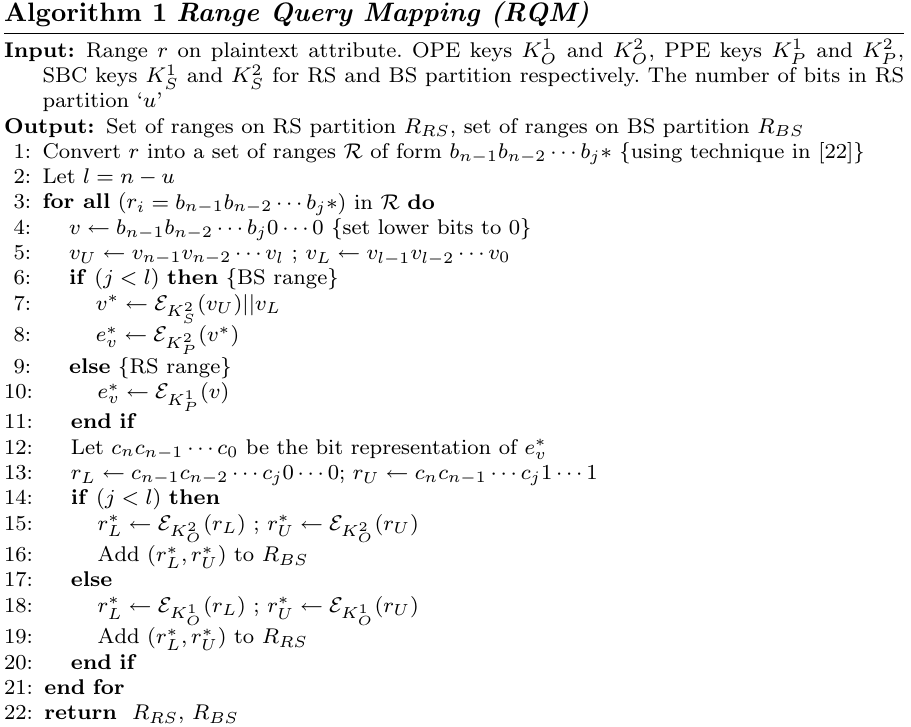
Algorithm 1 Range Query Mapping